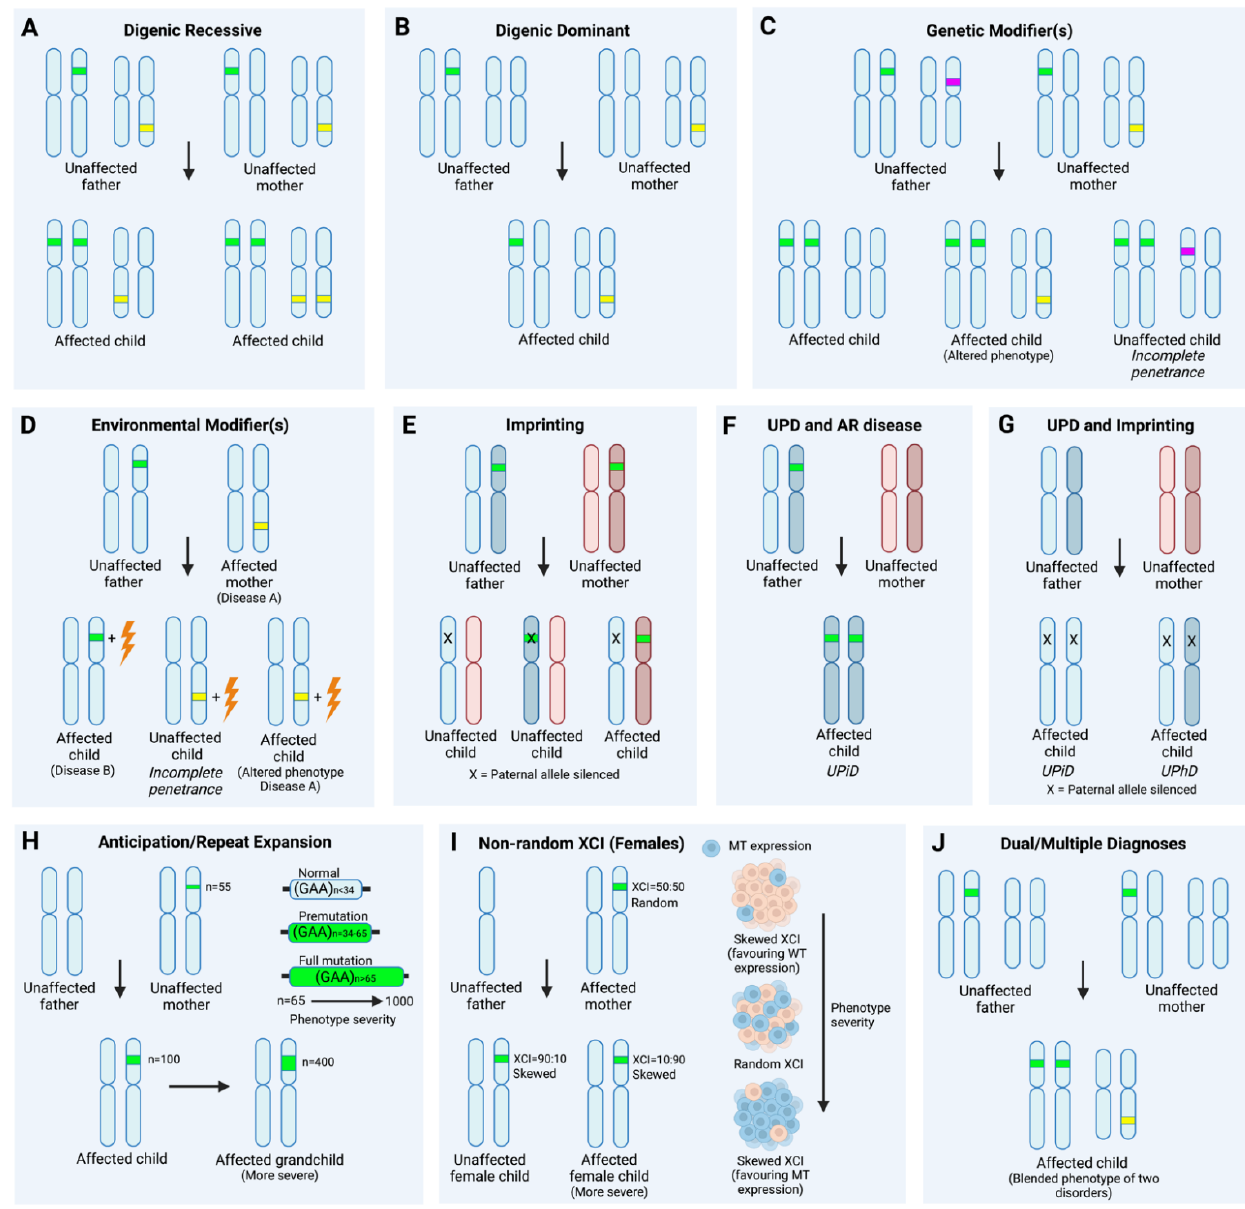
Figure 1. Complex inheritance models to consider in genetically undiagnosed cases, including non-Mendelian inheritance models and dual/multiple diagnoses. ( A , B ) Digenic inheritance models, the simplest form of multigenic inheritance. In digenic inheritance, variants at two genomic loci are needed for the manifestation of disease. Digenic inheritance, as classified according to OMIM, can be: ( A ) Recessive, with a biallelic mutant locus 1 together with a variant at a second locus (monoallelic or biallelic at locus 2); ( B ) Dominant, where monoallelic variants at two distinct loci are needed for expression of a disease. ( C ) Genetic modifiers can change the expression of a child’s phenotype and even lead to no observable phenotype (incomplete penetrance). An example of Autosomal Recessive (AR) inheritance is displayed, but modifiers can influence all inheritance models. Genetic modifiers may be rare or common. The presence of multiple rare variants (higher mutational burden) may be associated with a more severe phenotype. ( D ) Environmental modifiers can change the expression of a child’s phenotype and lead to no observable phenotype, i.e., incomplete penetrance (Disease A). In some cases, an environmental trigger is necessary for a phenotype to express (Disease B). ( E ) Imprinting at a certain locus, exemplified here by the silencing of the